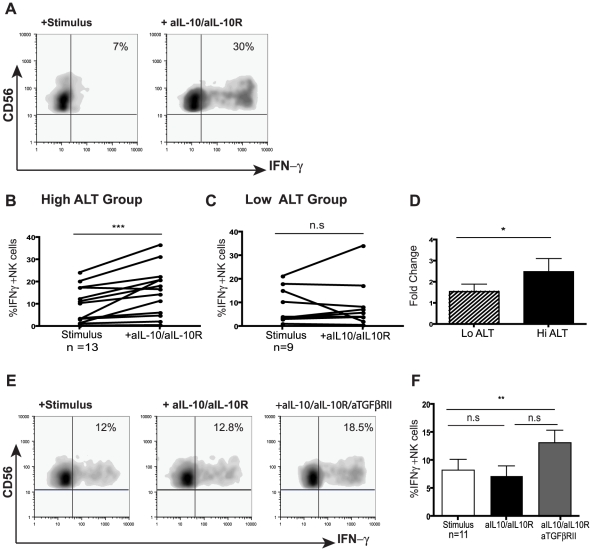
IL-10 blockade alone or in combination with TGFβRII blocking restores NK cell IFN-γ production.(A) Representative density plot from a CHB patient of peripheral NK cell IFN-γ production in the presence of anti-IL-10 and anti-IL10 receptor blocking mAb. (B) Paired summary data from CHB patients with either active disease (High ALT median 104, n = 13) or (C) inactive disease (Low ALT median 33, n = 9). (D) Fold change in IFN-γ produced by total NK cells following IL-10 blockade in both groups of patients. (E, F) Representative density dot plots from a CHB patient and summary bar chart of paired results from 11 patients (n = 11 median ALT 42) of NK cell IFN-γ production following IL-10 blockade alone or in combination with anti-TGFβRII blocking antibodies. Stimulus = IL12+IL18. Significance determined by the Mann-Whitney test for comparison between groups and the Wilcoxon signed rank test for paired data, *p<0.05, **p<0.01.